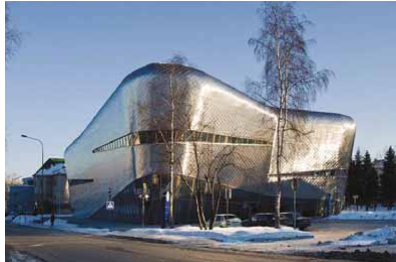
19 pav. Nacionalinės Velso asamblėjos interjeras, Kardifo įlanka, Jungtinė Karalystė, archit. R. Rogers, 2006 m. Fig. 19. The National Assembly of Wales, interior view, Cardiff bay, United Kingdom, archit. R. Rogers, 2006